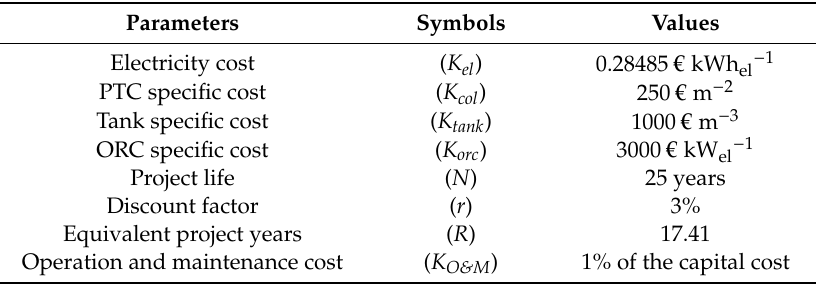
Table 1. Data for financial analysis [28,33].